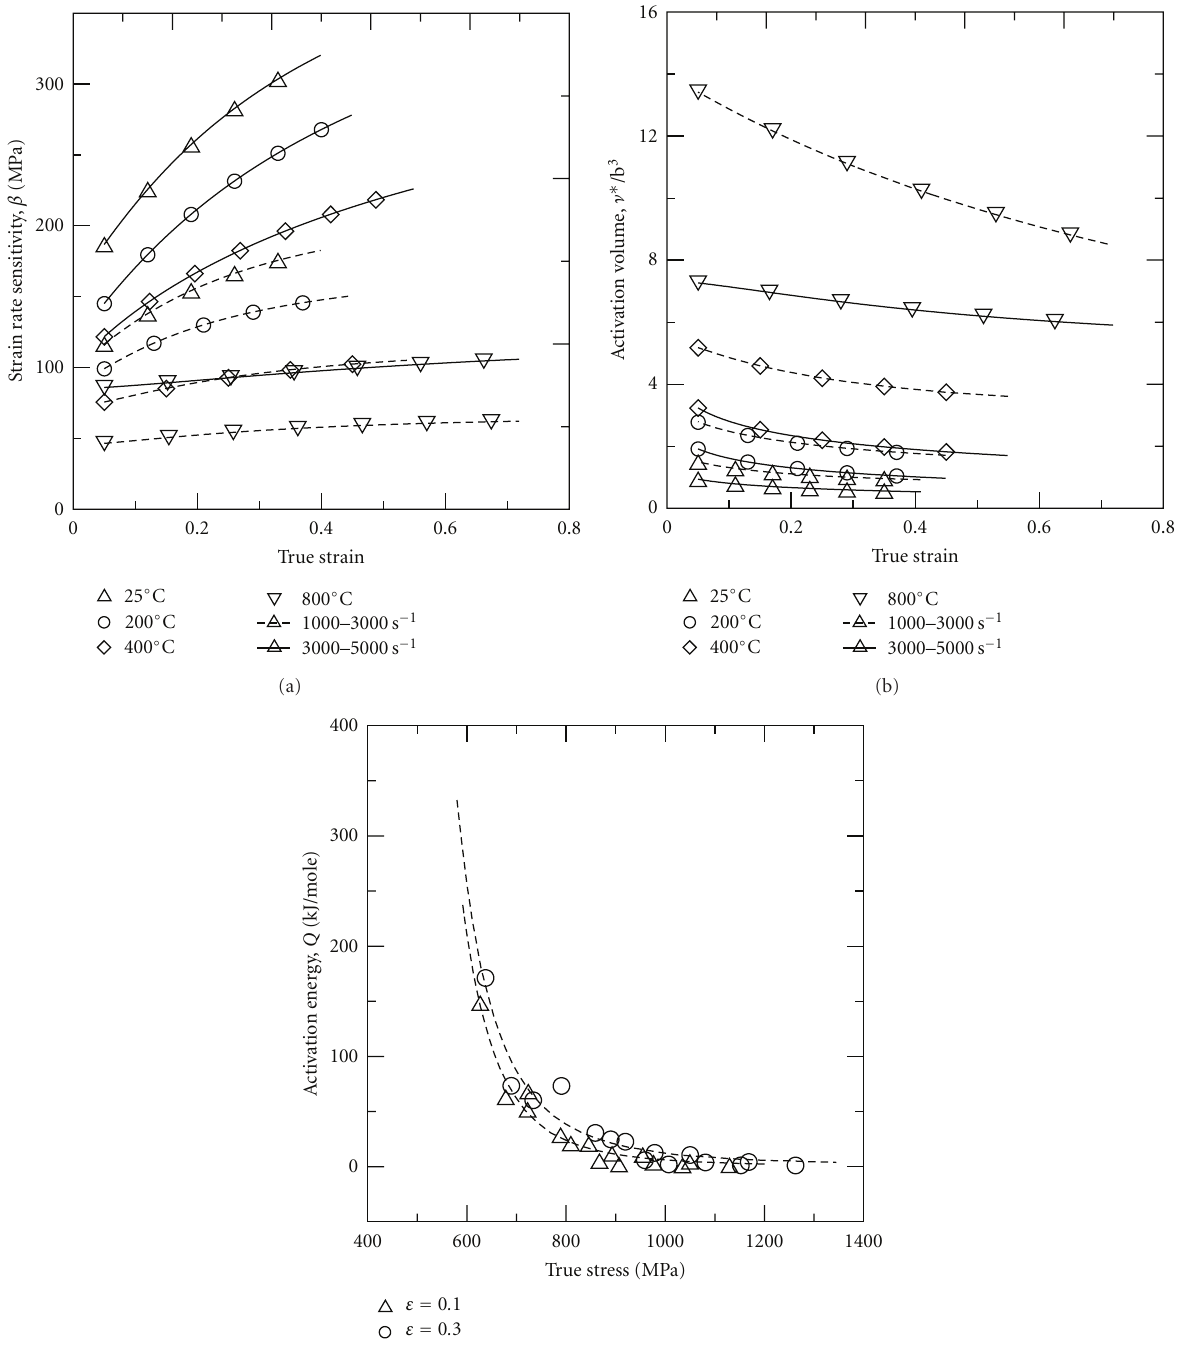
Figure 6: (a) Variation of strain rate sensitivity of 316L stainless steel with true strain as function of temperature and strain rate; (b) variation of activation volume of 316L stainless steel with true strain as function of temperature and strain rate; (c) variation of thermal activation energy of 316L stainless steel with true stress as function of true